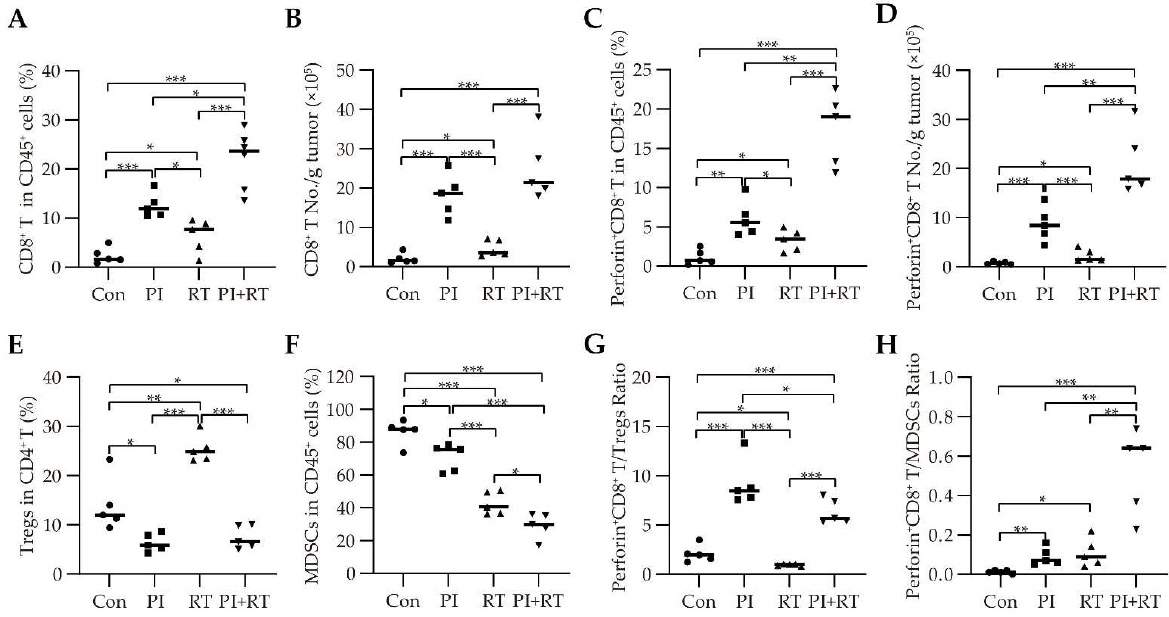
Figure 6. The effect of PI in combination with RT on the immune profiles in tumor tissues in subcutaneous lung cancer-bearing mice. Lymphocytes were isolated from tumors on day 19 post inoculation ( n = 5). ( A ) Proportion of CD8 + T cells in CD45 + cells. ( B ) Absolute number of CD8 + T cells. ( C ) Proportion of perforin + CD8 + T cells in CD45 + cells. ( D ) Absolute number of perforin + CD8 + T cells. ( E ) Proportion of Tregs in CD4 + T cells. ( F ) Proportion of MDSCs in CD45 + cells. ( G ) Ratio of perforin + CD8 + T cells to Tregs. ( H ) Ratio of perforin + CD8 + T cells to MDSCs. Absolute number was presented as the number of cells per gram of tumor. The statistical differences between groups were analyzed with an unpaired two-tailed Student’s t-test. The data showed the mean ± SEM. Statistical differences were indicated by the p values, *, p ≤ 0.05; **, p ≤ 0.01; ***, p ≤ 0.001.